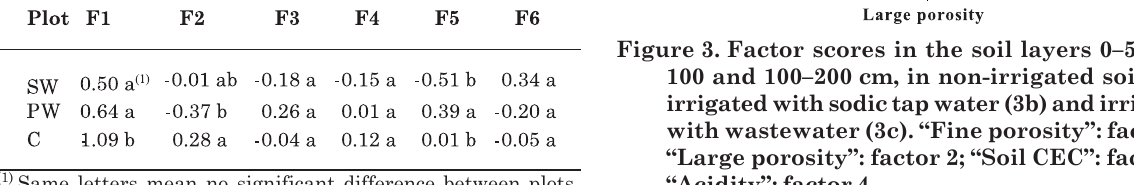
(1) Same letters mean no significant difference between plots.